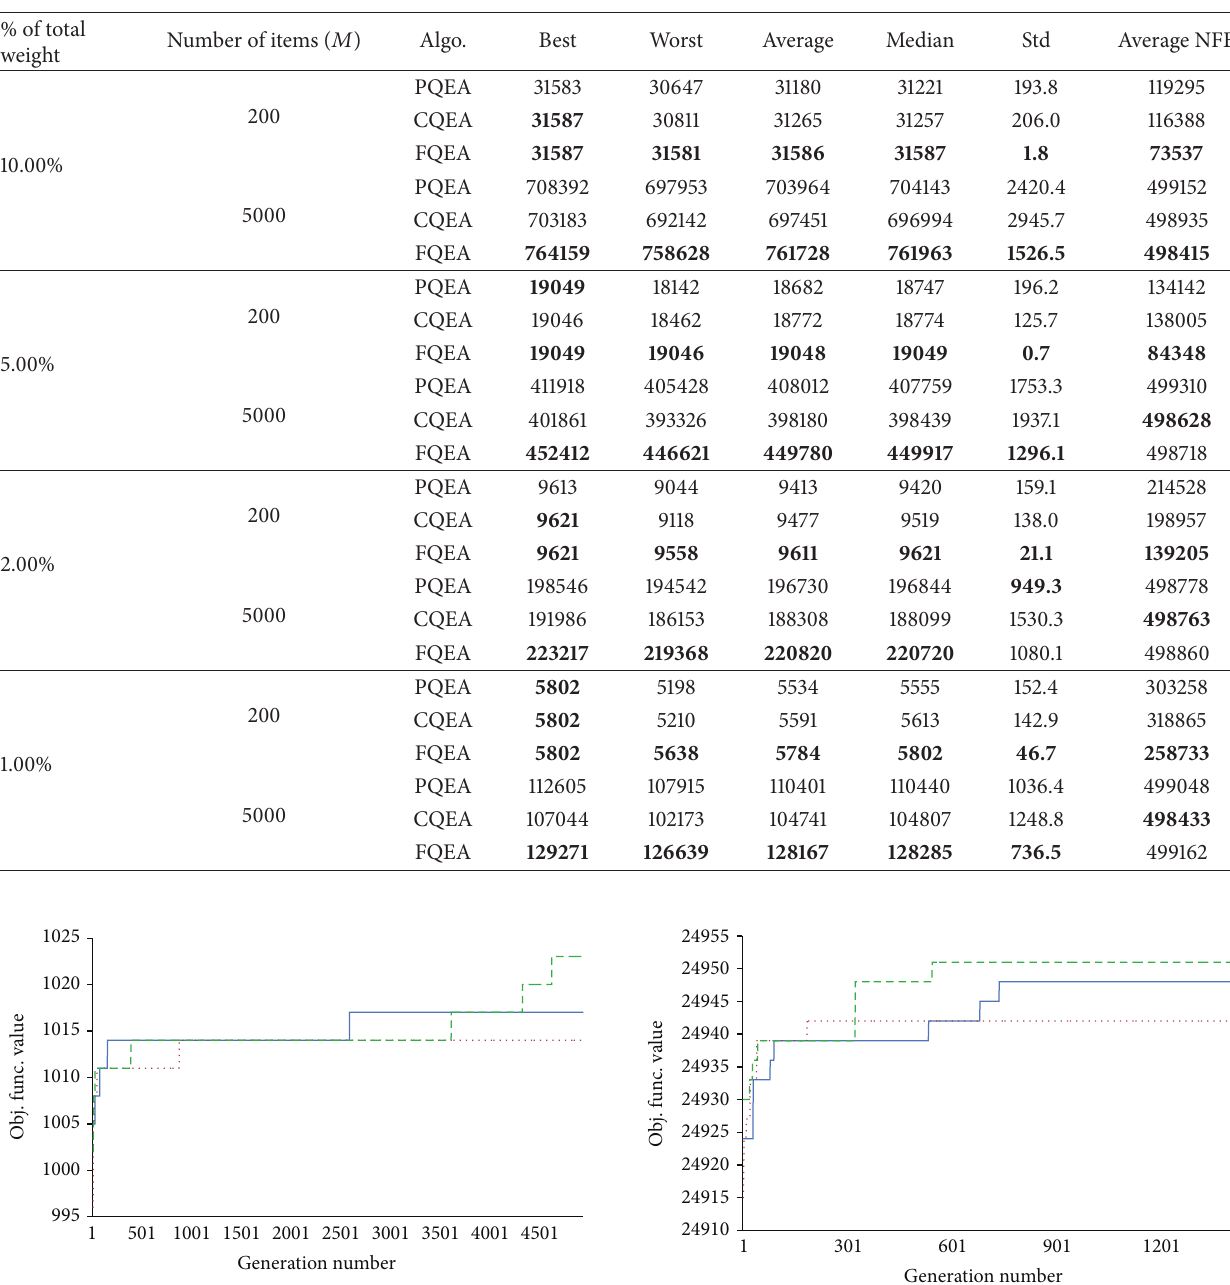
Table 6: Comparative study between PQEA, CQEA, and FQEA using statistical results on 0-1 knapsack problem with circle data instances. % of total weight